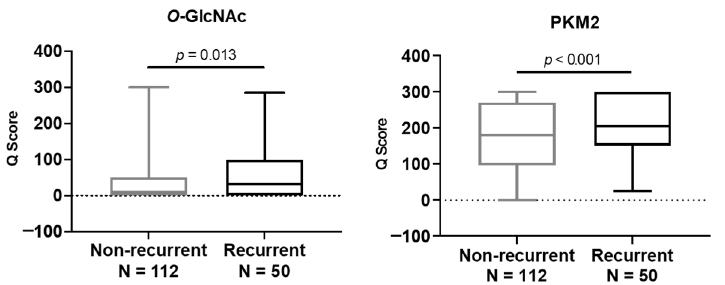
Figure 5. High O -GlcNAc or high PKM2 expression is significantly associated with the risk of re-